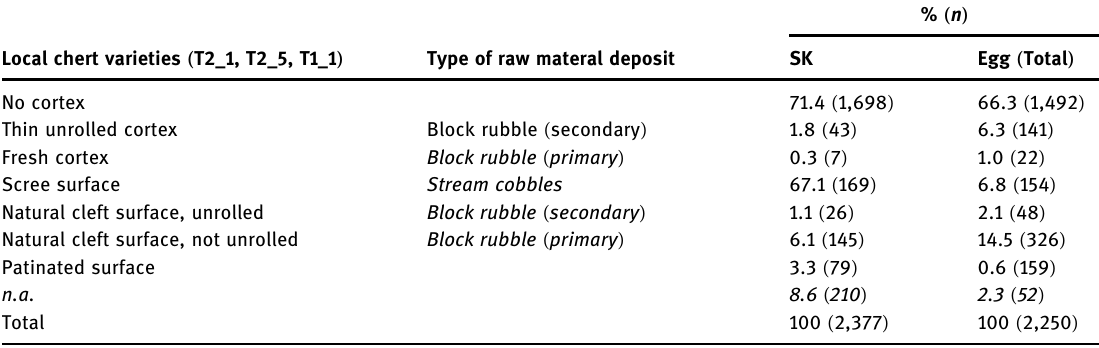
Table 16: Cortex types and coverage sorted after potential raw material deposits ( Schneiderküren and Egg - Schwarzwasser ) Local chert varieties ( T2_1, T2_5, T1_1